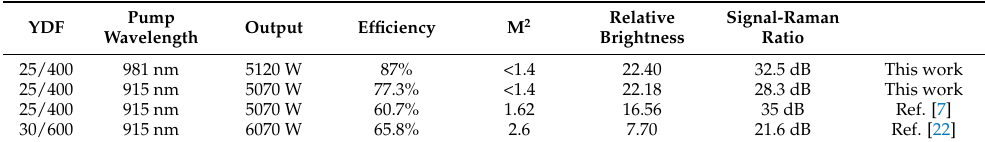
Table 2. Comparison of output performances among different oscillators.